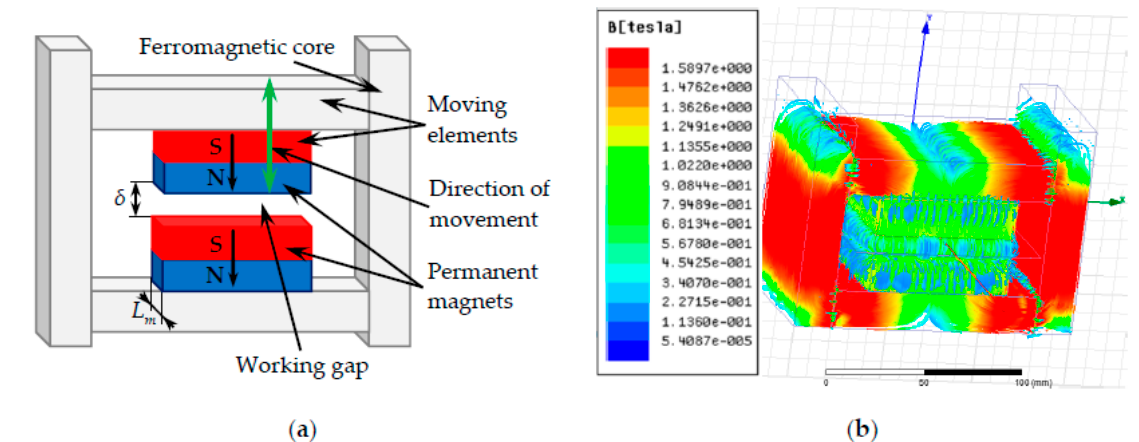
Figure 9. Exciter: ( a ) structure and ( b ) magnetic field distribution.